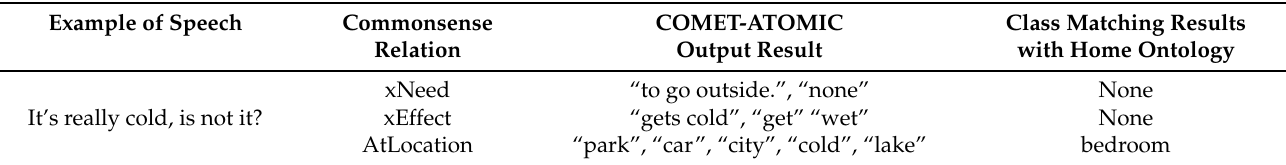
Table 8. COMET-ATOMIC input/output results and class matching results for the failed exam- ple